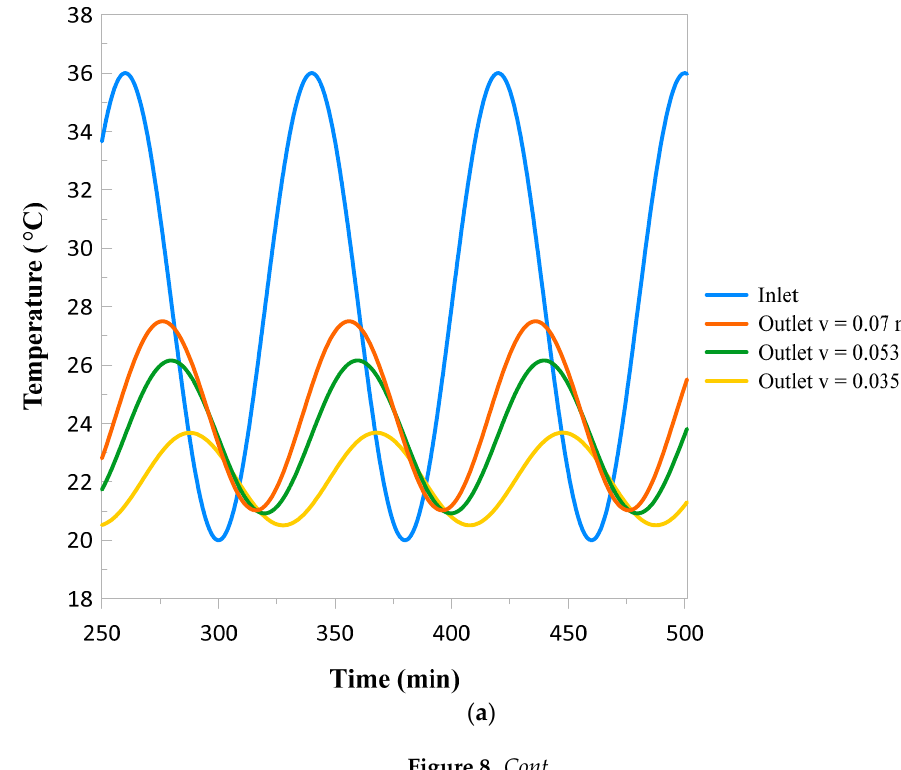
Table 7. Input and output wave characteristics with different